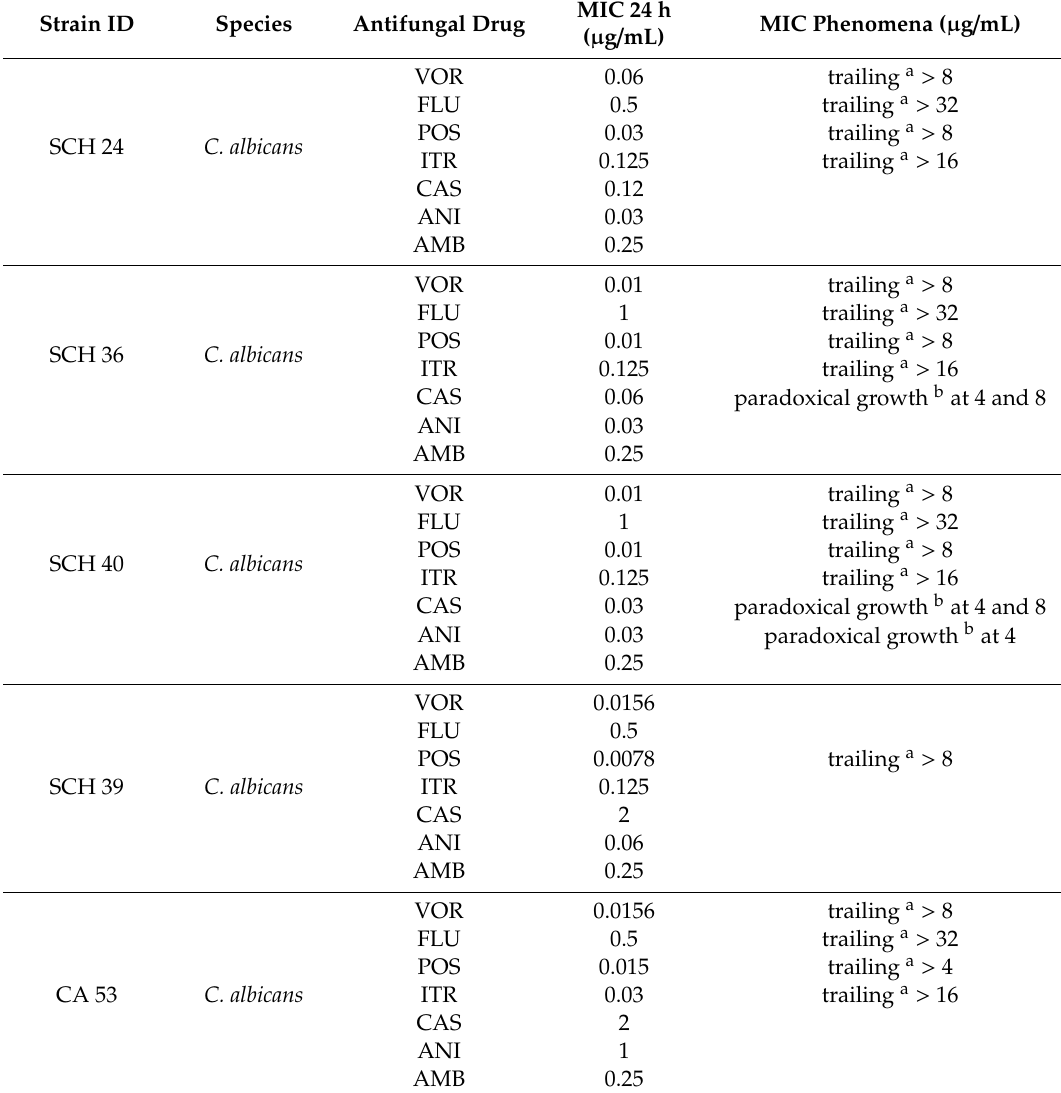
Table 1. Overview on selected clinical isolates of Candida albicans used for in vivo evaluation in Galleria mellonella and their minimal inhibitory concentration (MIC)-phenomena determined by a EUCAST